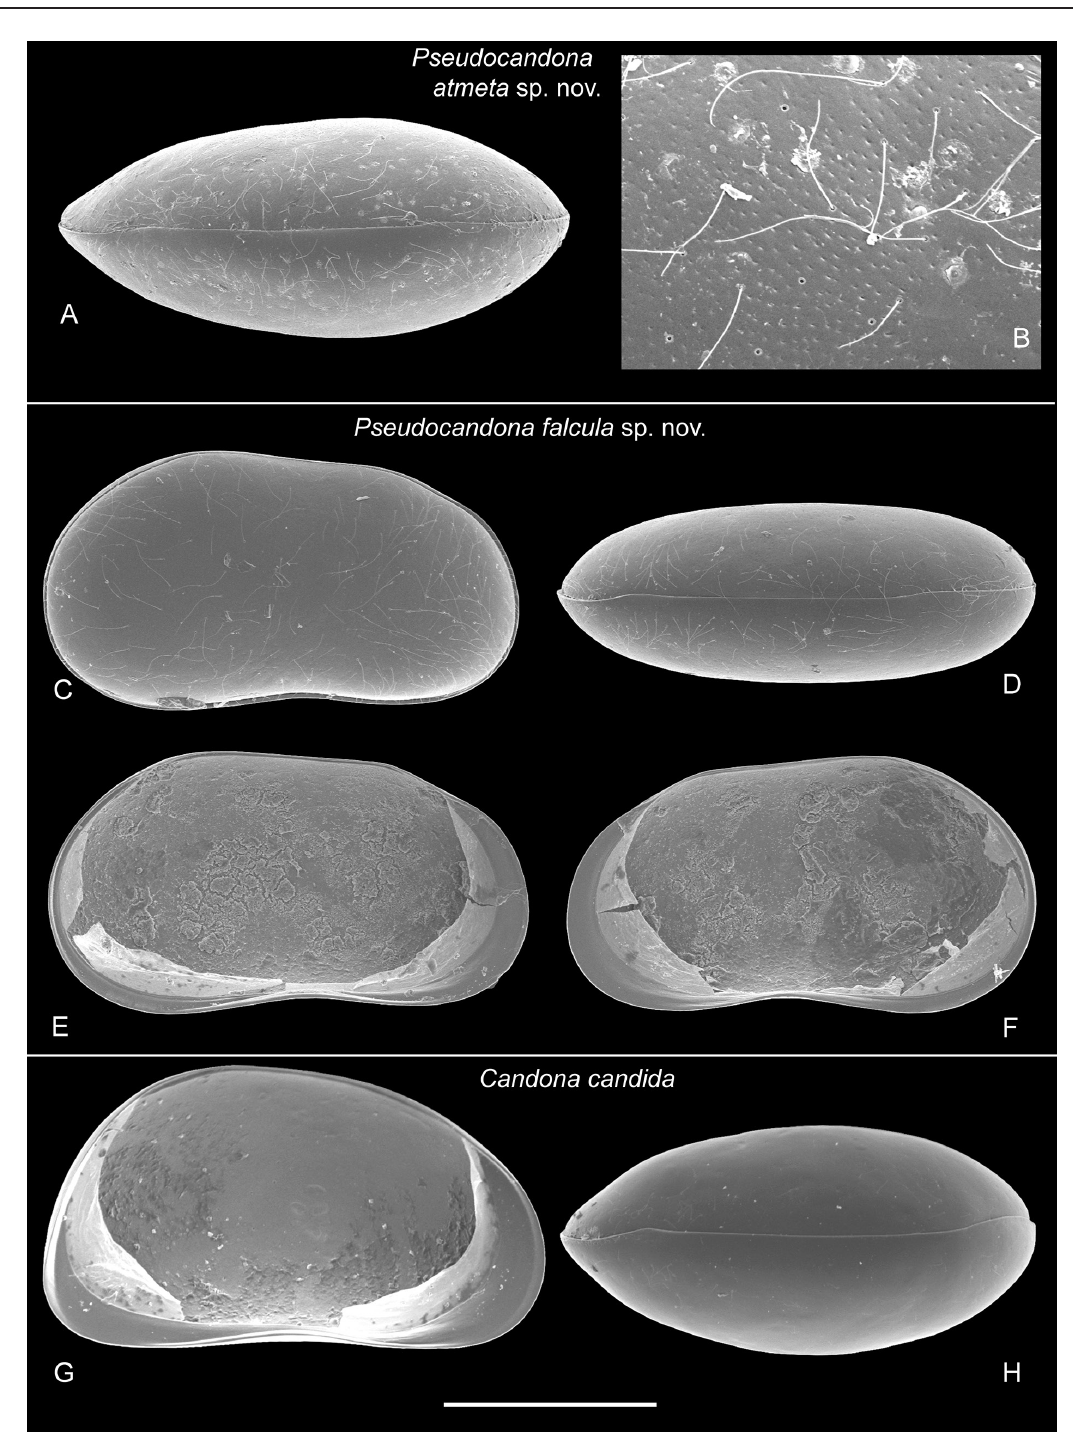
Fig. 7. A–B . Pseudocandona atmeta sp. nov. A . Dorsal view of male carapace, anterior to left (LBM 1430006272). B . Detail of external surface of male right valve (LBM 1430006272). C–F . Pseudocandona falcula sp. nov. C . Right view of female carapace (LBM 1430006278). D . Dorsal view of female carapace, anterior to left (LBM 1430006278). E . Internal view of female left valve (LBM 1430006277). F . Internal view of female right valve (LBM 1430006277). G–H . Candona candida (O.F. Müller, 1776) G . Internal view of female left valve. H . Dorsal view of female carapace, anterior to left. Scale bar: A, C–F = 500 µm; B = 134 µm; G–H = 412